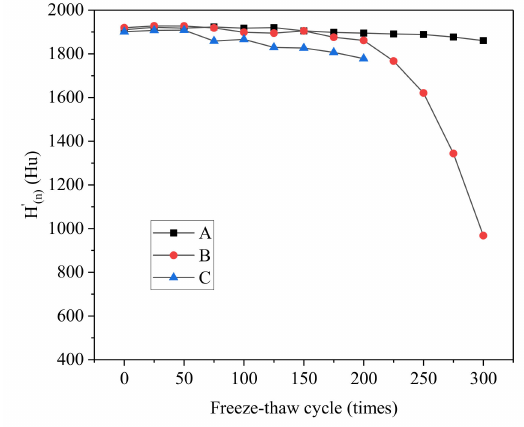
Figure 15. Evolution of the relative CT